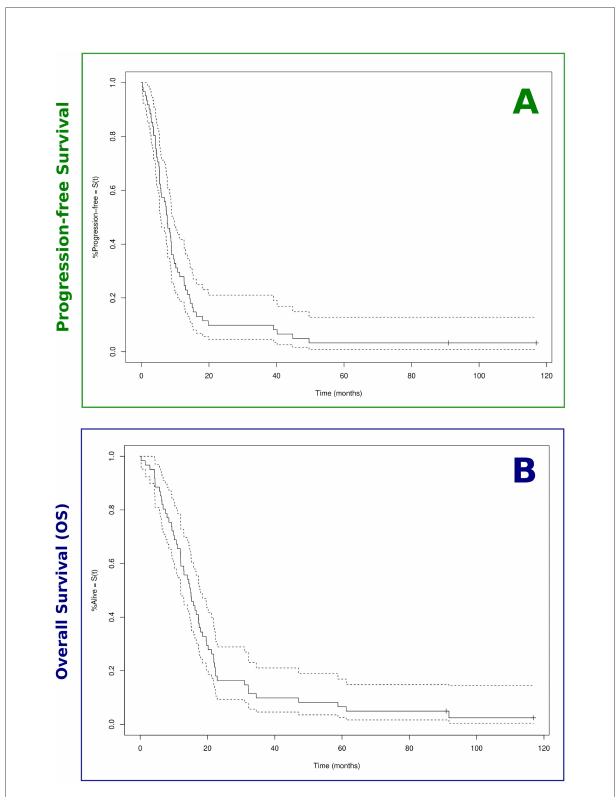
FIGURE 4 | Kaplan – Meier survival curves. Estimated survival proportions according to Kaplan – Meier are displayed for the full patient cohort (n = 61). (A) Median progression-free survival (PFS) was 7.6 months. (B) Overall survival (OS) was 15.0 months (OS; cf. Table 2 ). The associated lower and upper bounds of the 95% con fi dence interval are displayed as dashed lines. Censoring events are indicated by vertical ‘ ticks ’ .